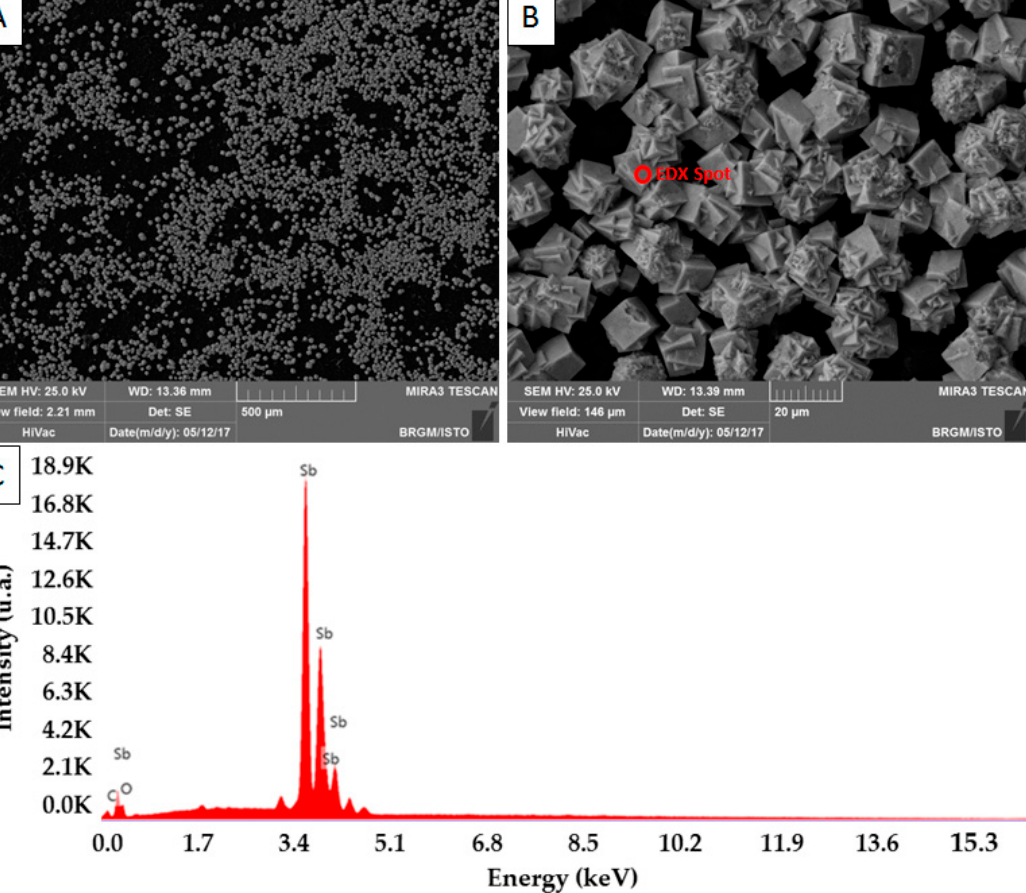
Figure 1. SEM-EDX analyses carried out on a freshly antimony-coated SPE. ( A ) Global view of the Sb-coated SPE working surface; ( B ) Close view of the Sb-coated SPE working surface; ( C ) EDX spectrum resulting of the analysis of the spot shown on Figure 1B.